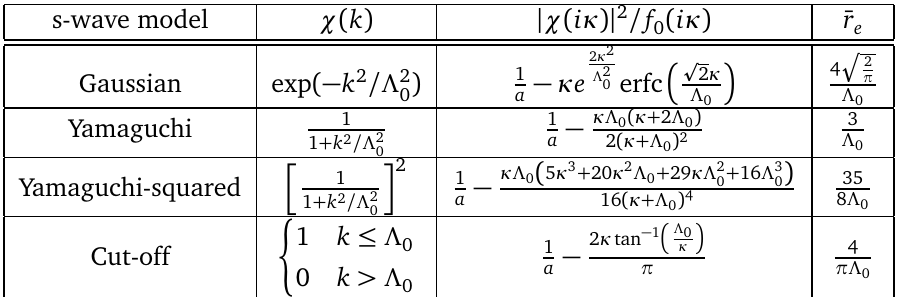
, and the parameter ¯ r e 0